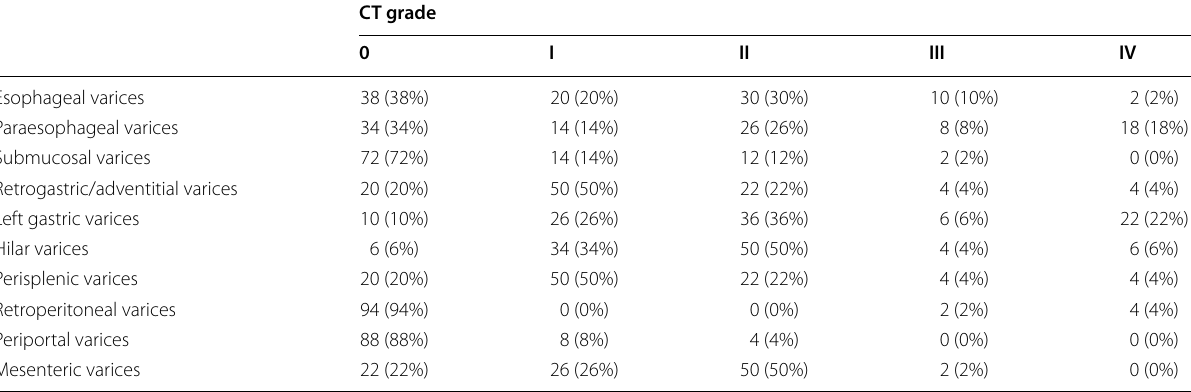
Table 3 Results of MDCT triphasic assessment of common collateral varices